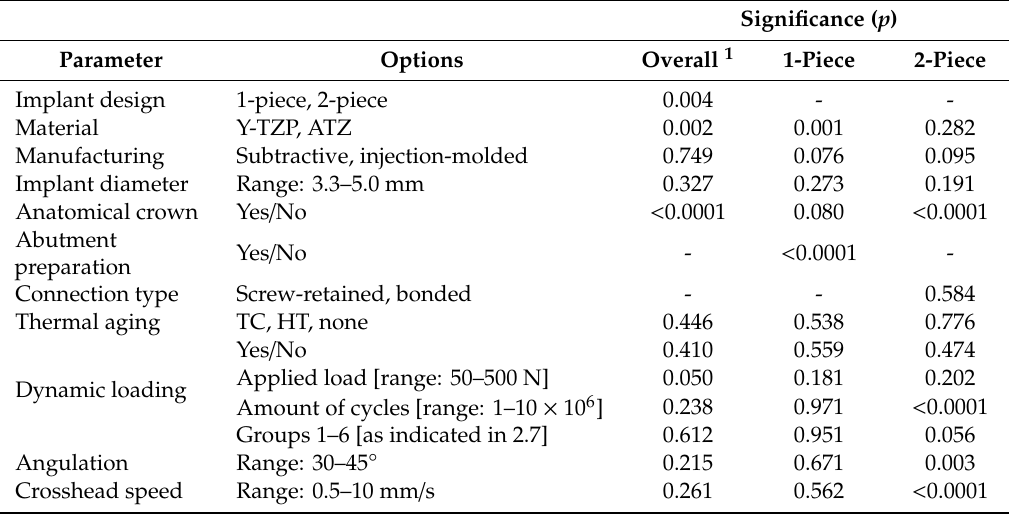
Table 4. Significance (linear mixed models (LMMs), level of significance p < 0.05) was calculated for di ff erences regarding the implant design, di ff erent covariables and treatments.